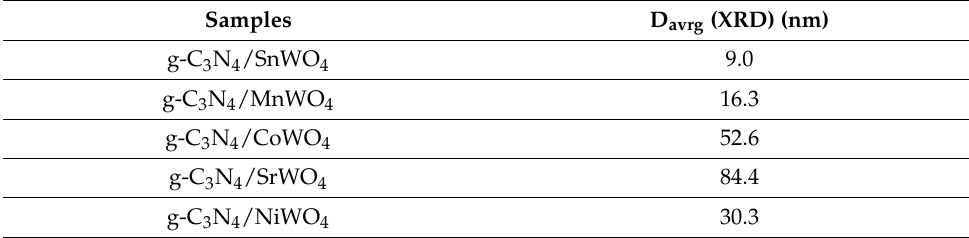
Table 1. Calculated values of D avrg .